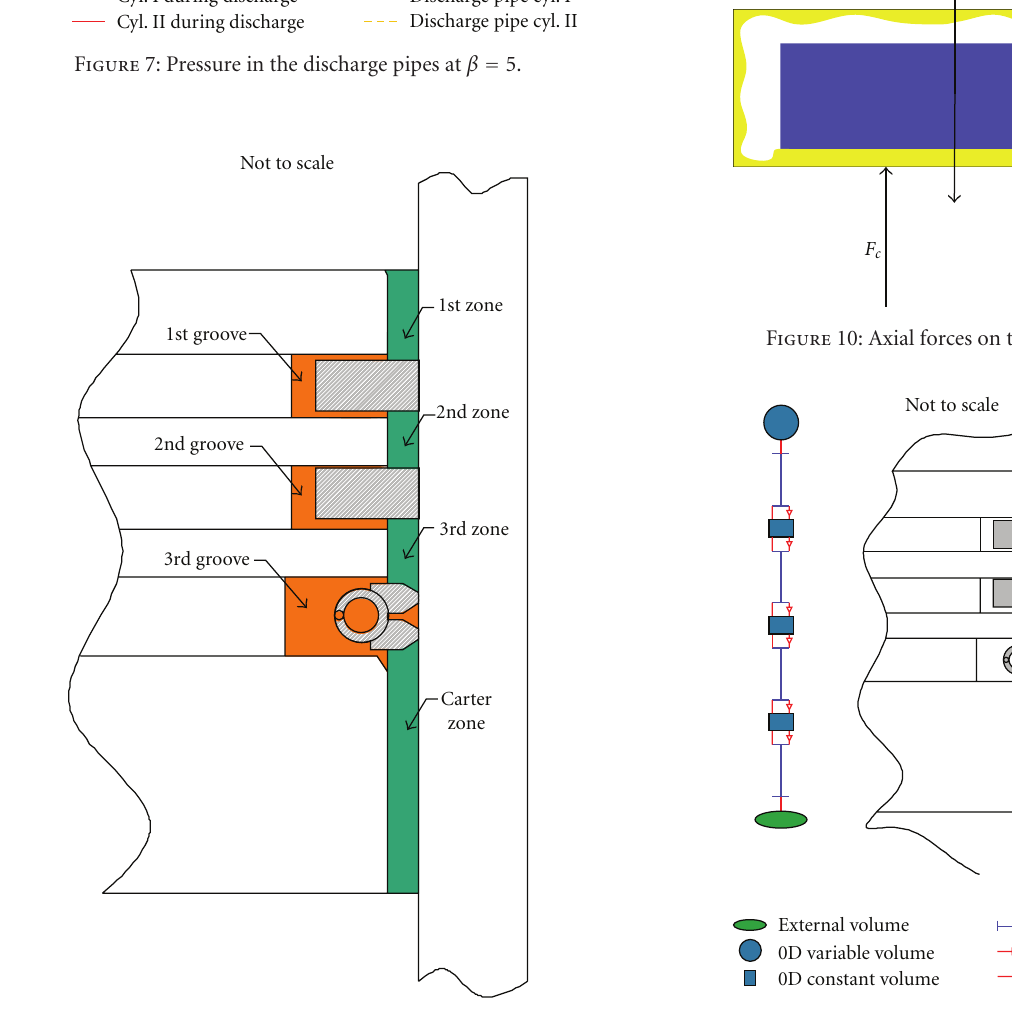
Figure 9: Ring gap.